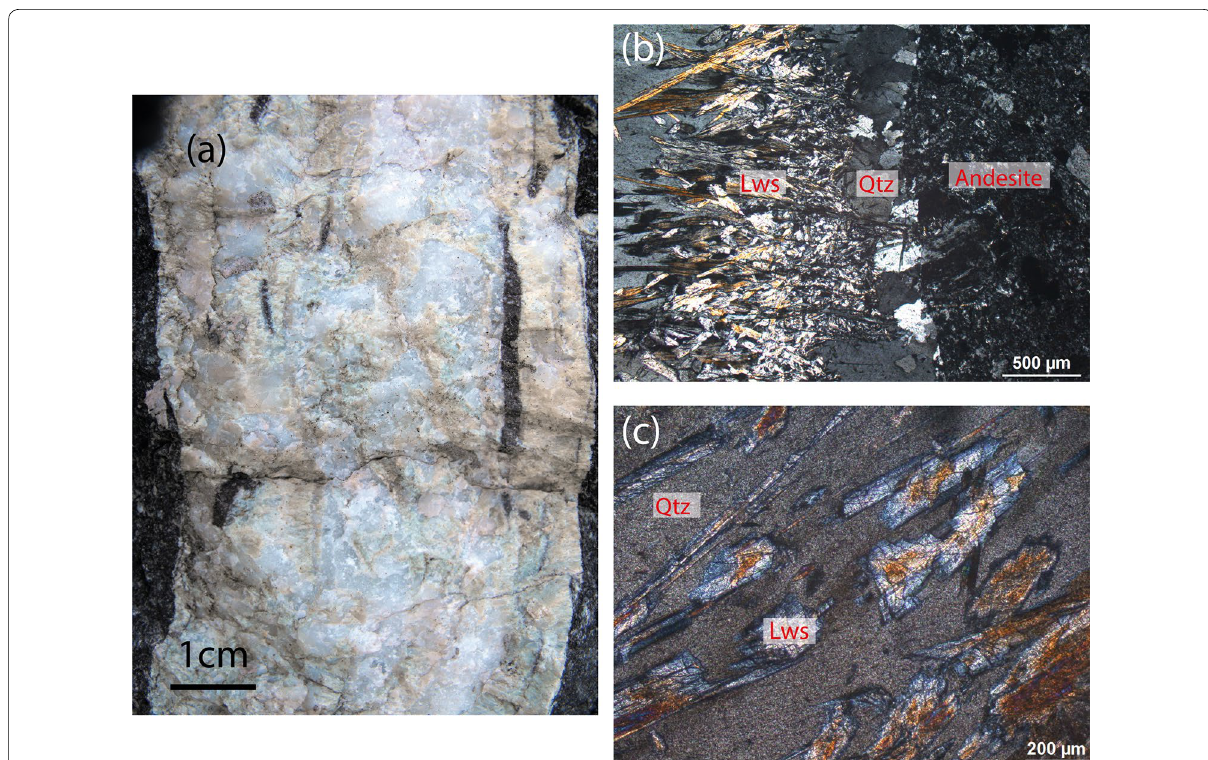
Fig. 9 Lawsonite veins in the Guil andesites. a Field aspect of the veins, with fibrous lawsonite localized along the vein walls, or against thin slices of wall rock (andesite) preserved inside the vein, showing several stages of opening. b , c Microphotographs of the vein, both in crossed-polarized light, showing the lawsonite (Lws) needles in a quartz (Qtz)